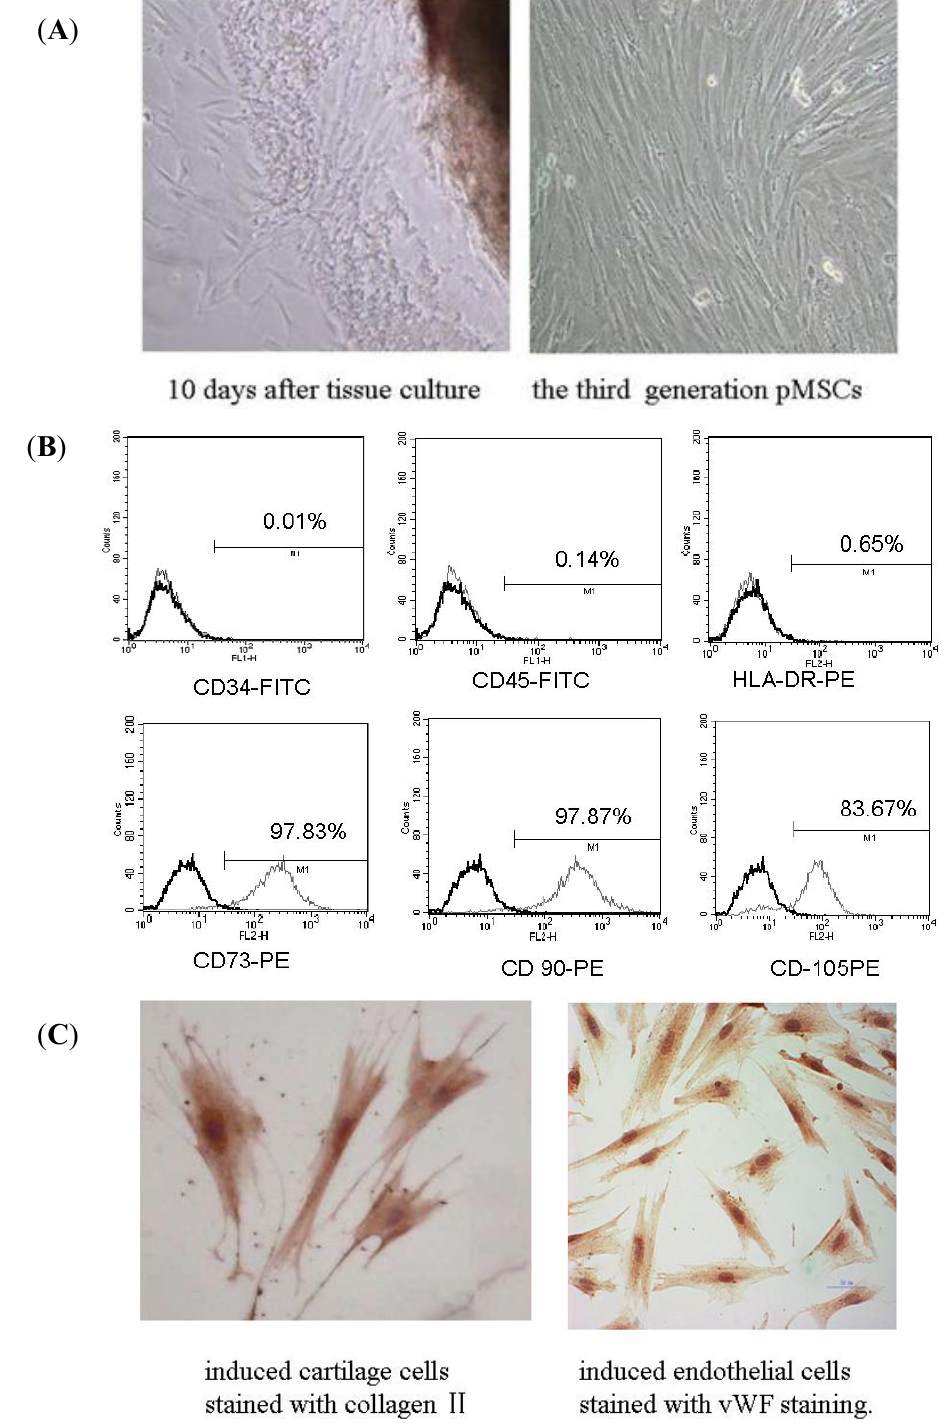
Figure 1. Isolation and identification of pMSCs. ( A ) Isolation of pMSCs by the method of tissue culture. Some cells appeared around tissues 10 days after culture. The third generation pMSCs had fibroblast-like morphology visualized by phase-contrast microscopy (100× magnification); ( B ) Flow cytometry assay of pMSCs: most of pMSCs were CD73, CD90 and CD105 positive; CD34, CD45 and HLA-DR negative; and ( C ) Differentiation ability of pMSCs: pMSCs can differentiate into cartilage cells and endothelial cells (400×